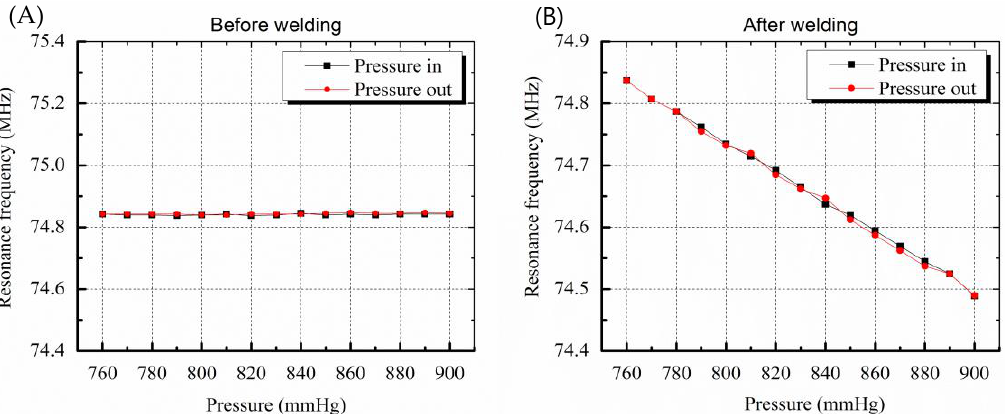
Figure 6. Graphs showing resonance frequency change by pressure variation. ( A ) Before welding, resonance frequency change as a function of membrane deformation caused by pressure variation is not shown due to leakage ( B ) resonance frequency variation due to deformation of membrane is clearly measured after welding.